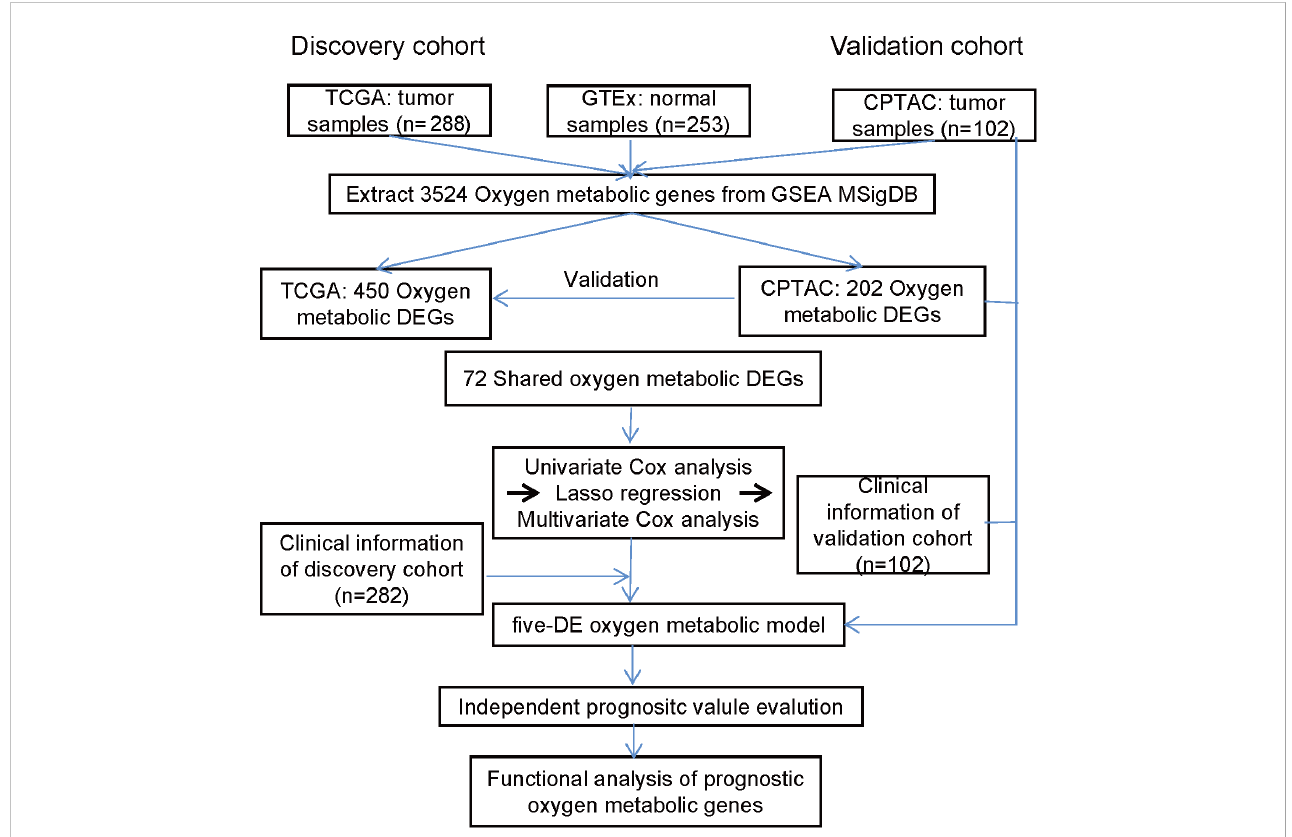
FIGURE 1 The work fl ow of this study. The prognostic model based on oxygen metabolism genes was established and validated in two independent CRC cohorts, and the roles of prognostic genes in CRC was further